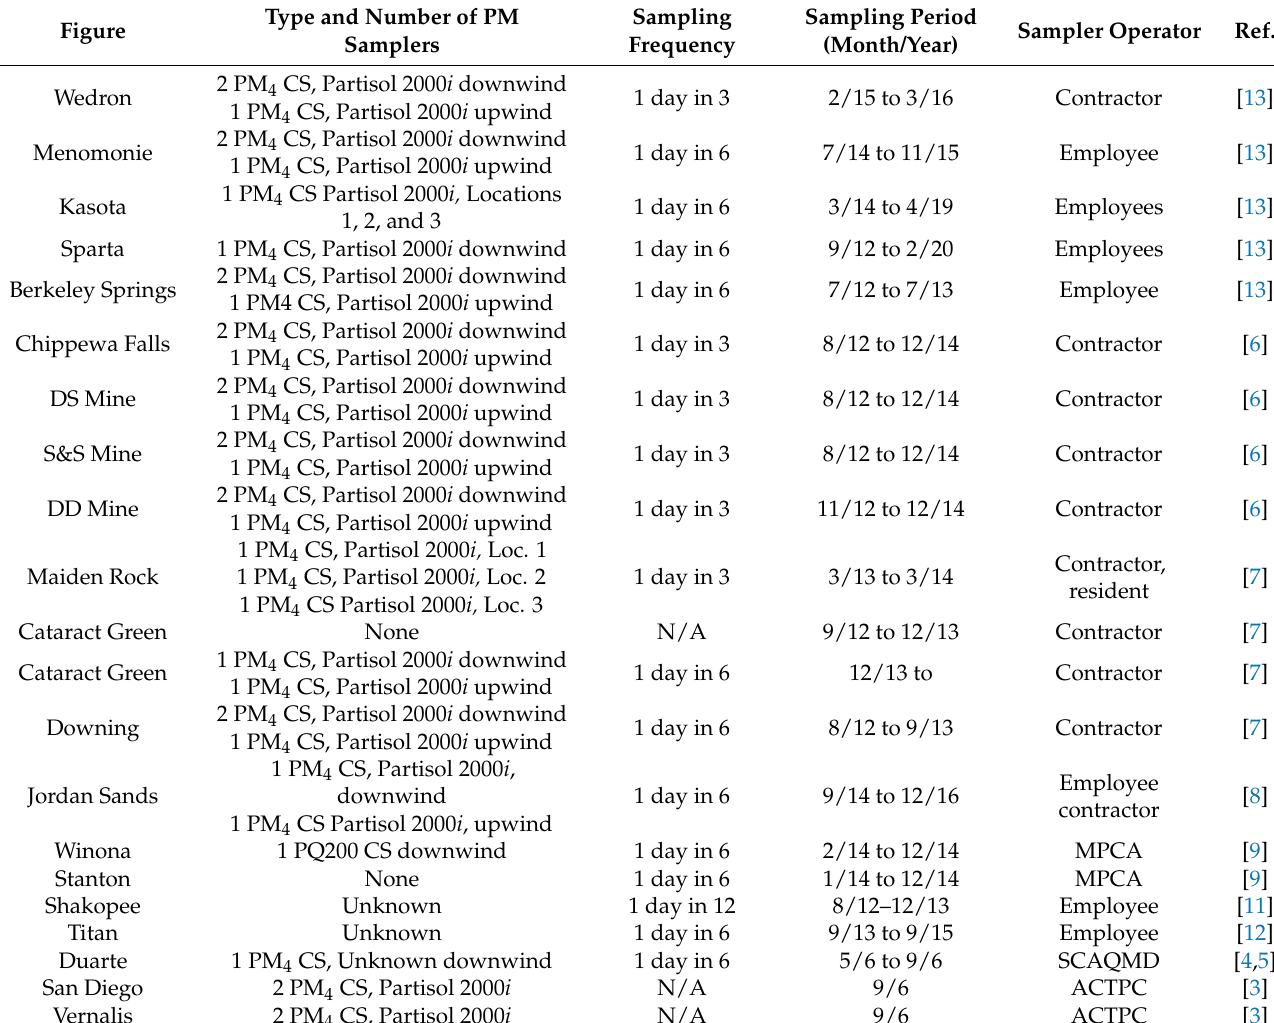
Sampler Operator